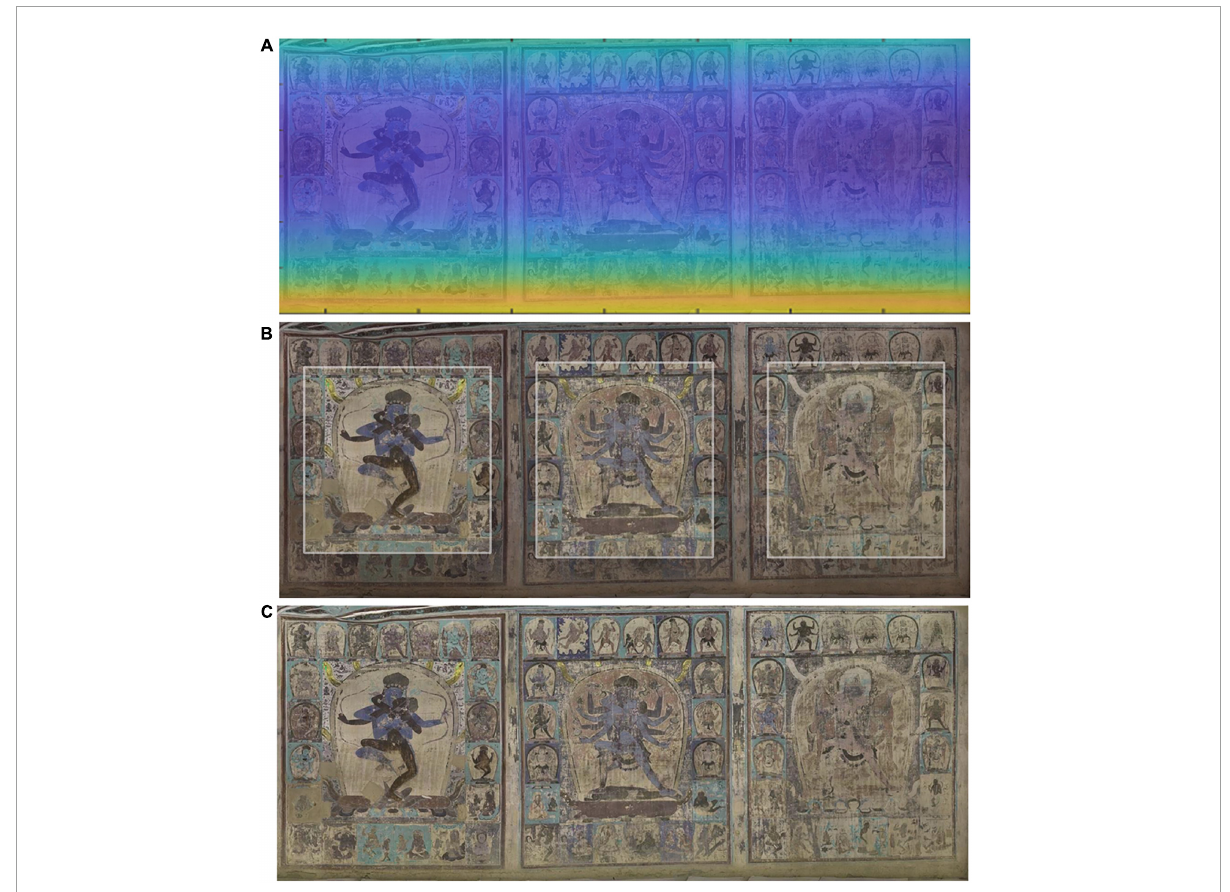
FIGURE12 The intermediate results for color cast image correction. (A) The scene’s illuminant chromaticity distribution estimation, (B) comparison of the murals before and after color correction. The inside area of the image is color corrected area while the outside frame of the image is the image in its current condition, (C) the image appearance after color